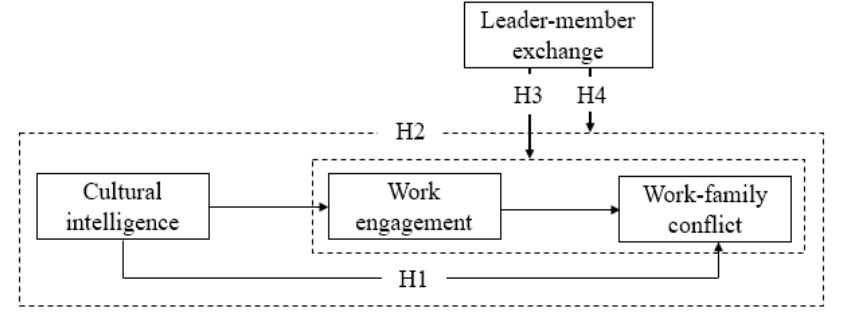
Figure 1. Theoretical model.